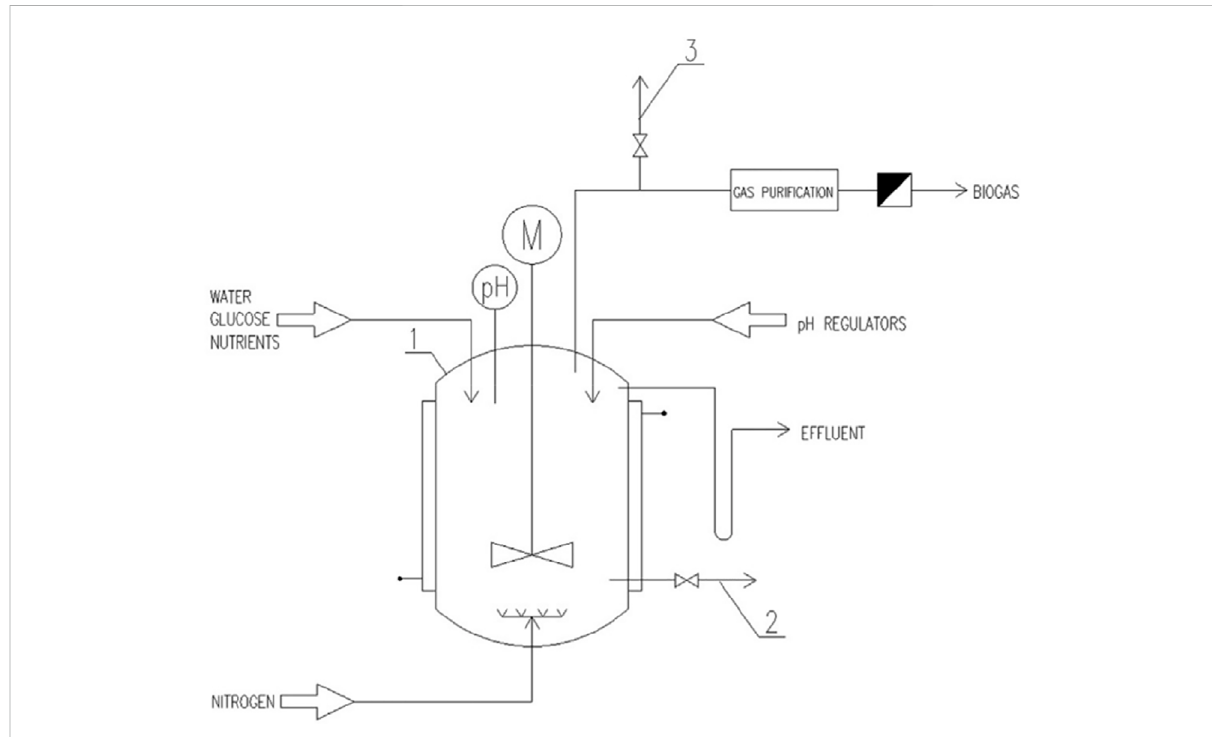
FIGURE 2 Schematic diagram of the CSTR reactor ( Ł ukajtis et al.,